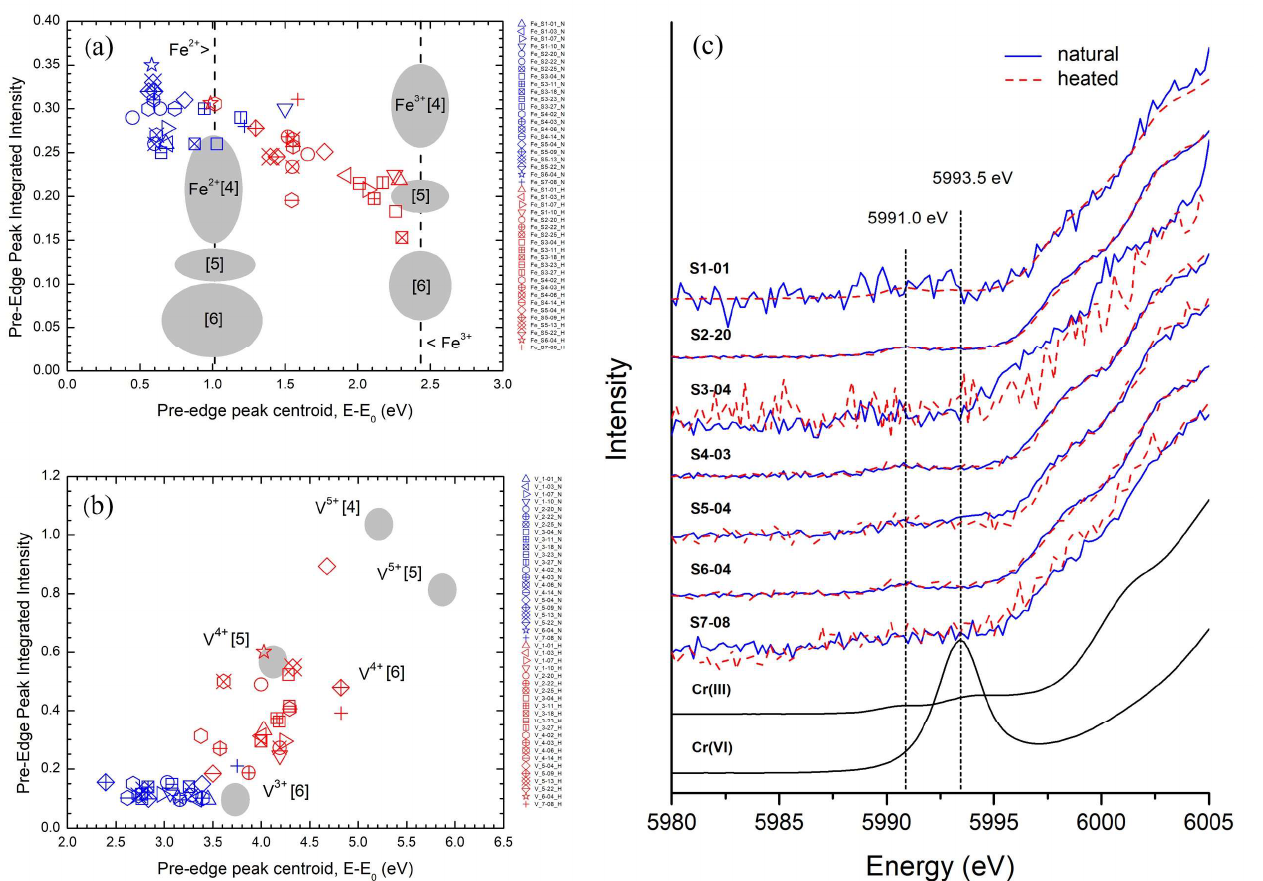
Figure 6. Diagrams present integrated pre-edge intensity and pre-edge peak centroid (E-E 0 ) parame- ter of all spinel samples in various ( a ) Fe- and ( b ) V-oxidation state and their coordination, whereas ( c ) represented normalized Cr pre-edge XANES spectra of natural (blue lines) and heated (red lines) spinels compared with Cr(III) and Cr(VI) standards. Number [4], [5] and [6] represent a 4-fold, 5-fold, and 6-fold coordinated atoms,